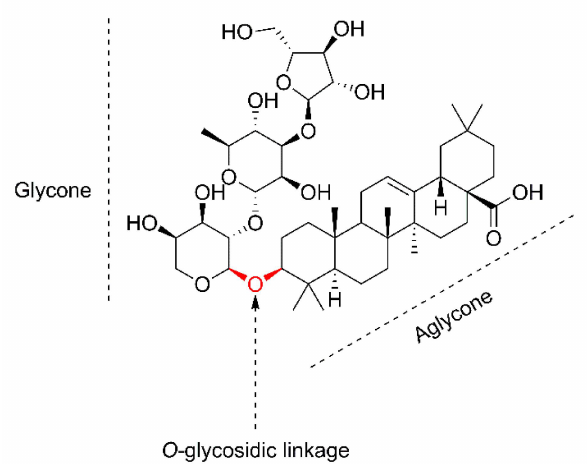
Figure 1. Chemical structure description of oleanolic acid saponin present in the pulp of S. mukorossi , isolated by Hu et al.